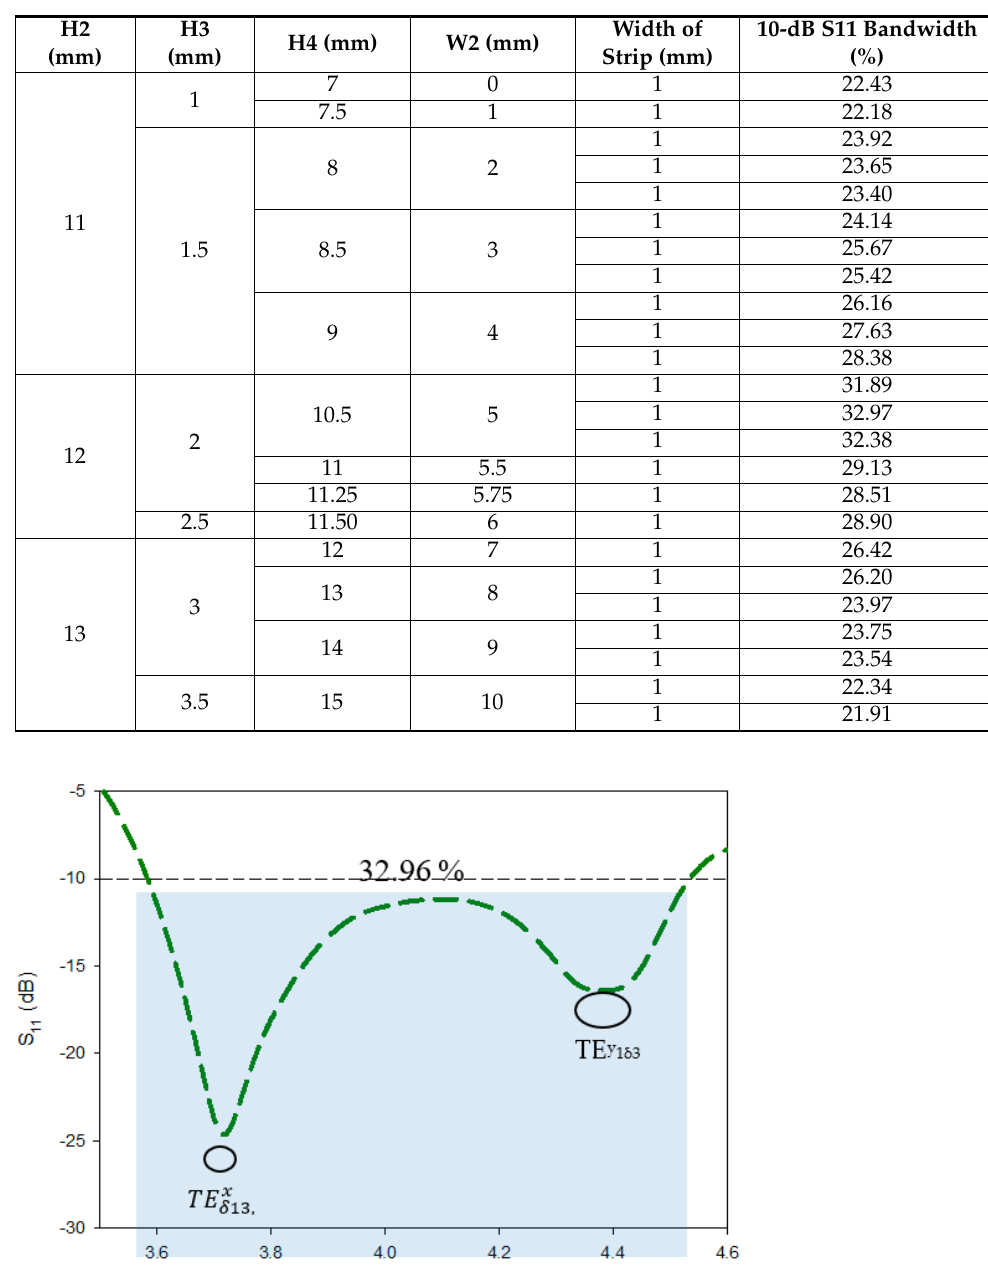
Table 3. Optimization of the Novel conformal strips (unit: mm).